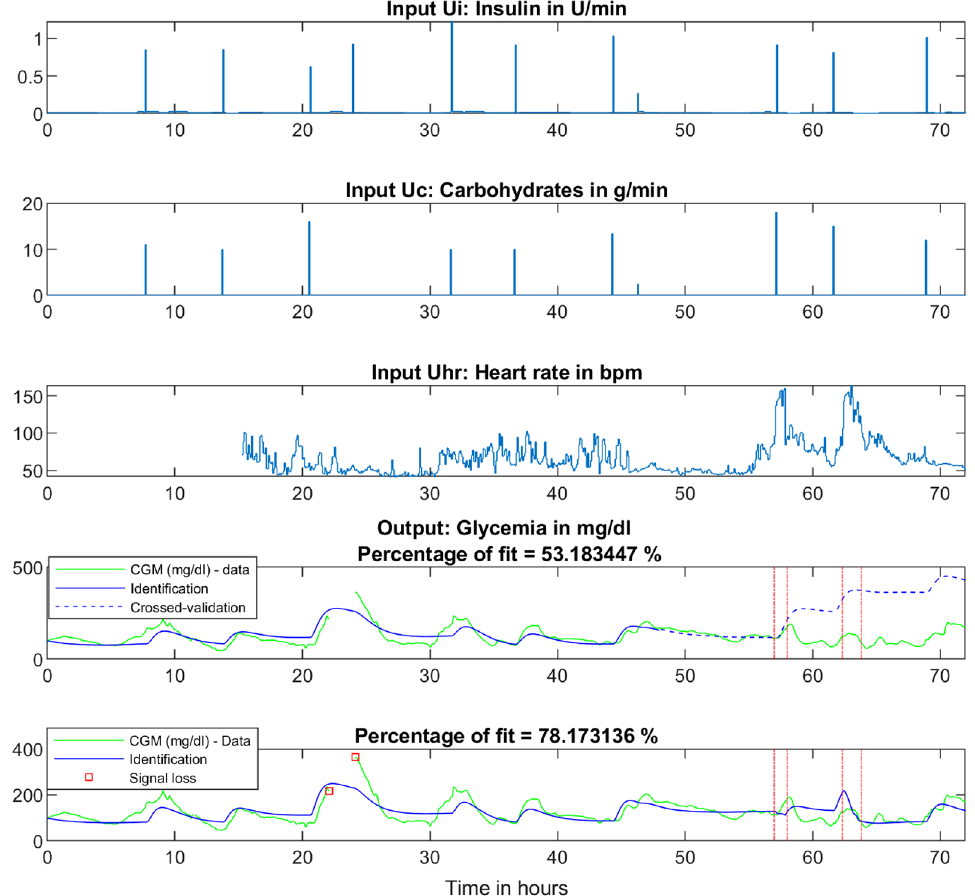
Figure 3. The identification procedure led by clinical data with a physical activity period. The upper panel represents the insulin input in [U/min]. These input data are retrieved from the patient’s insulin pump. The second panel pictures meal intakes in [g/min] which are declared by the patient. The third graph and last input is the heart rate, which is acquired using a smartwatch with a plethysmograph. During the first 15 h, the heart rate sensor malfunctions, and we assume that the heart rate remains at a reference value of 55 bpm as the actimetry data show no exertion. The fourth panel shows an identification procedure performed over 48 h via a model without physical activity equations followed by a crossed-validation of 24 h, showing that the model fails and quickly diverges after the onset of exertion. The last graph considers the same 72 h of data while conducting identification on the whole data set with the extended FIT model (including physical activity). The four red vertical lines the delimit two physical activity periods where exertion is deemed